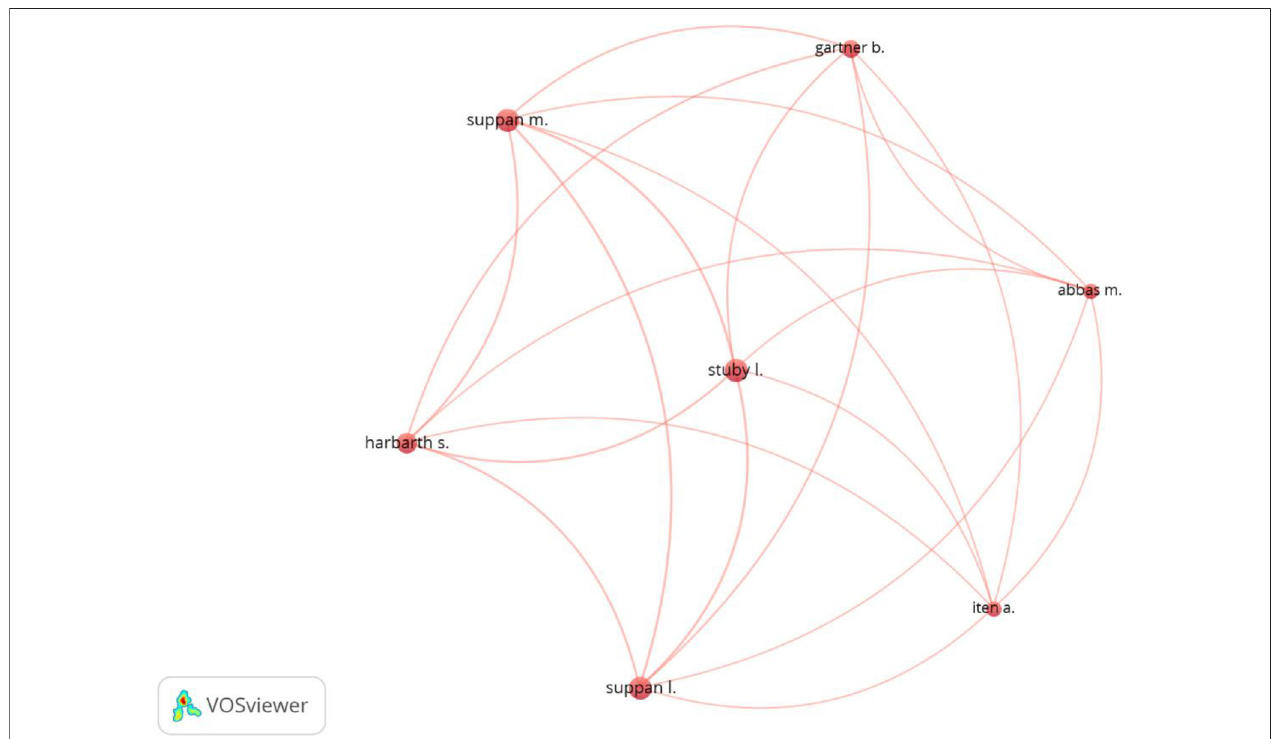
FIGURE 3 | Network map of author